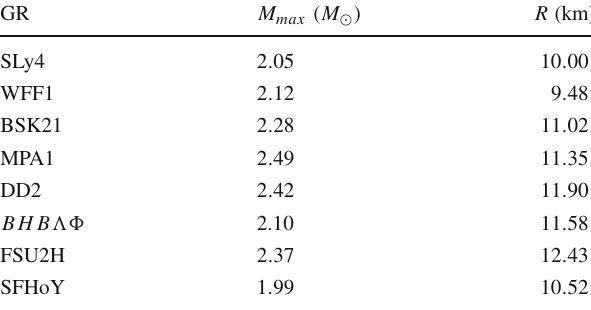
Table 1 The maximum mass and corresponding radius for the different EoSs in GR